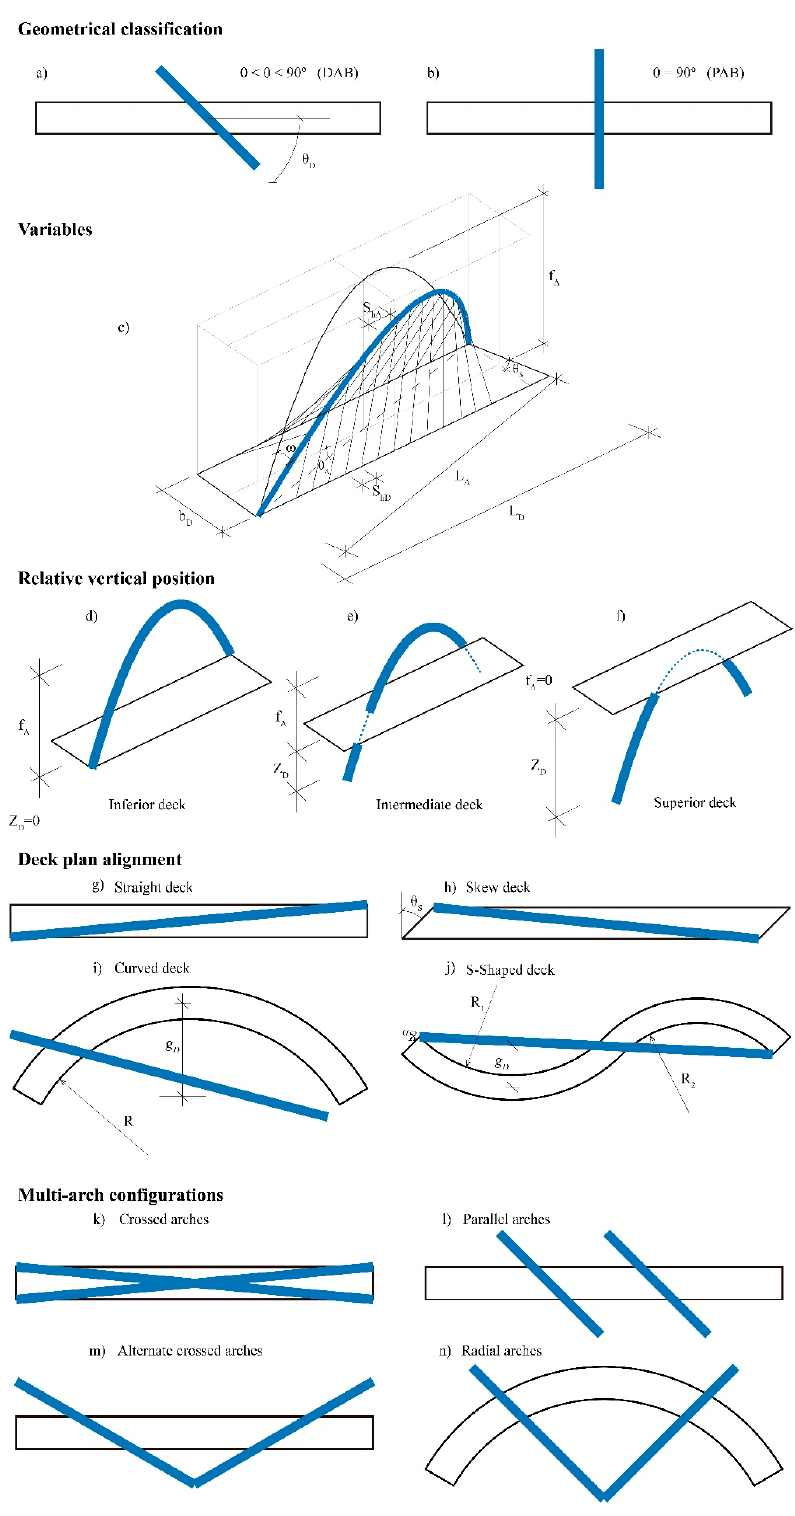
Figure 21. Geometrical parameters and classification of the diagonal arch bridge (DAB). ( a ) Geometrical classification of the DAB, ( b ) Geometrical classification of the PAB, ( c ) Variables of the diagonal arch bridge, ( d ) Inferior deck, ( e ) Intermediate deck, ( f ) Superior deck, ( g ) Straight deck, ( h ) Skew deck, ( i ) Curved deck, ( j ) S-Shaped deck, ( k ) Crossed arches, ( l ) Parallel arches, ( m ) Alternate crossed arches, ( n ) Radial arches.